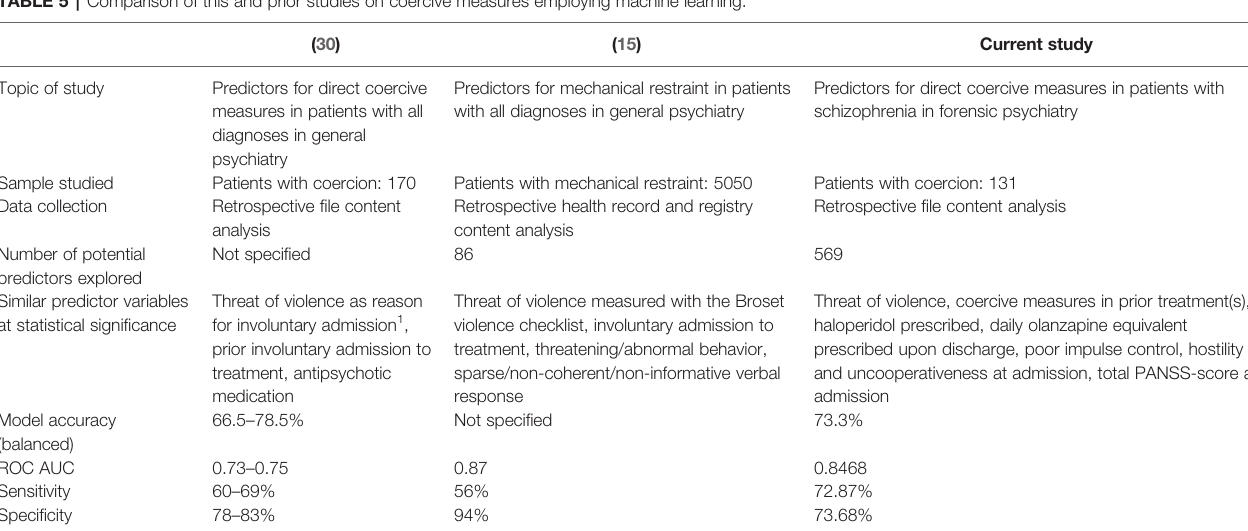
TABLE 5 | Comparison of this and prior studies on coercive measures employing machine learning.